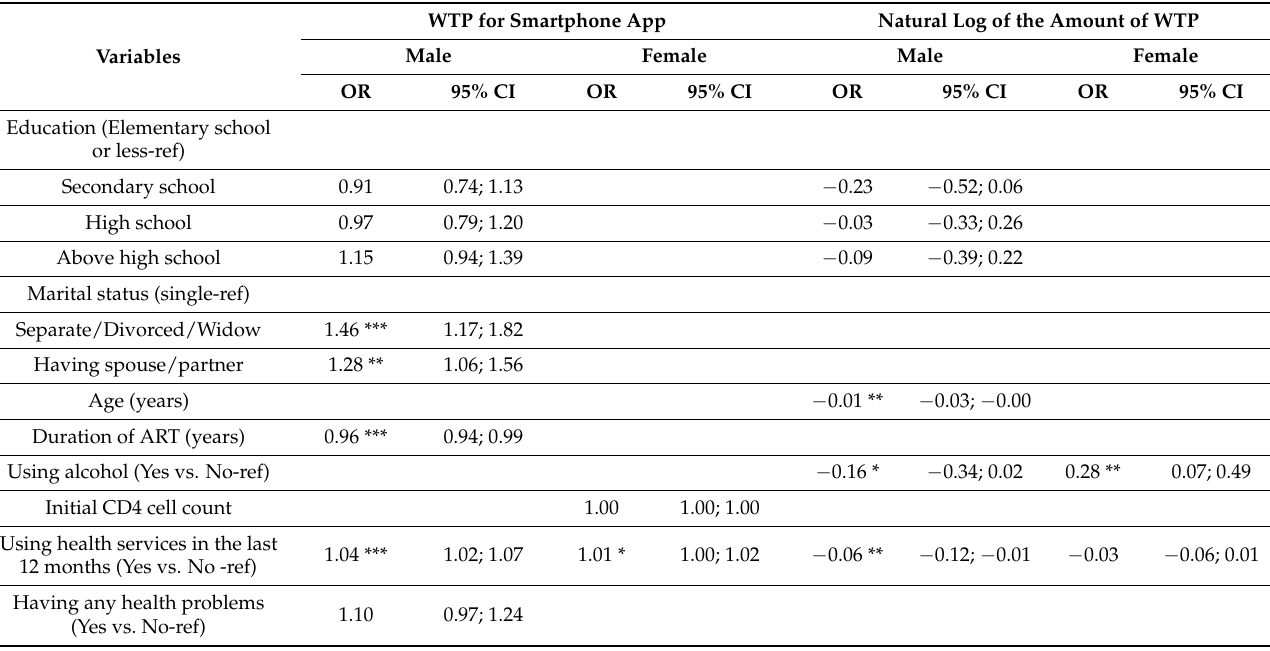
Table A2. Associated factors with WTP and the amount of WTP stratified by sex.